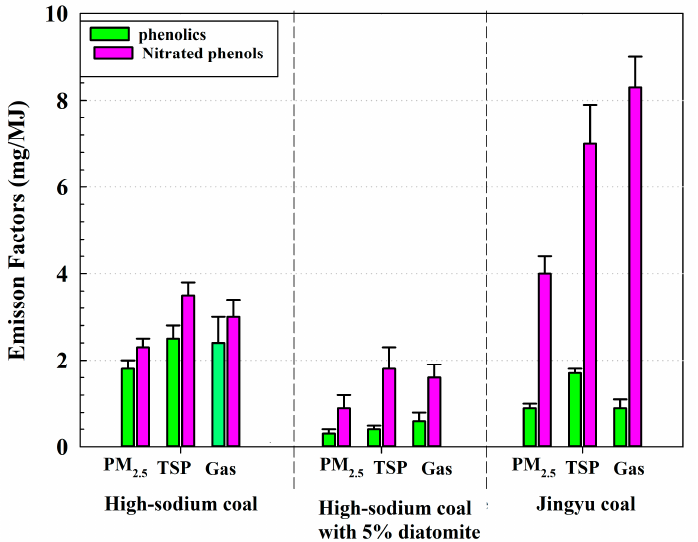
Figure 1. EFs of phenolics and nitrated phenols in PM 2.5 , TSP and gas phase.